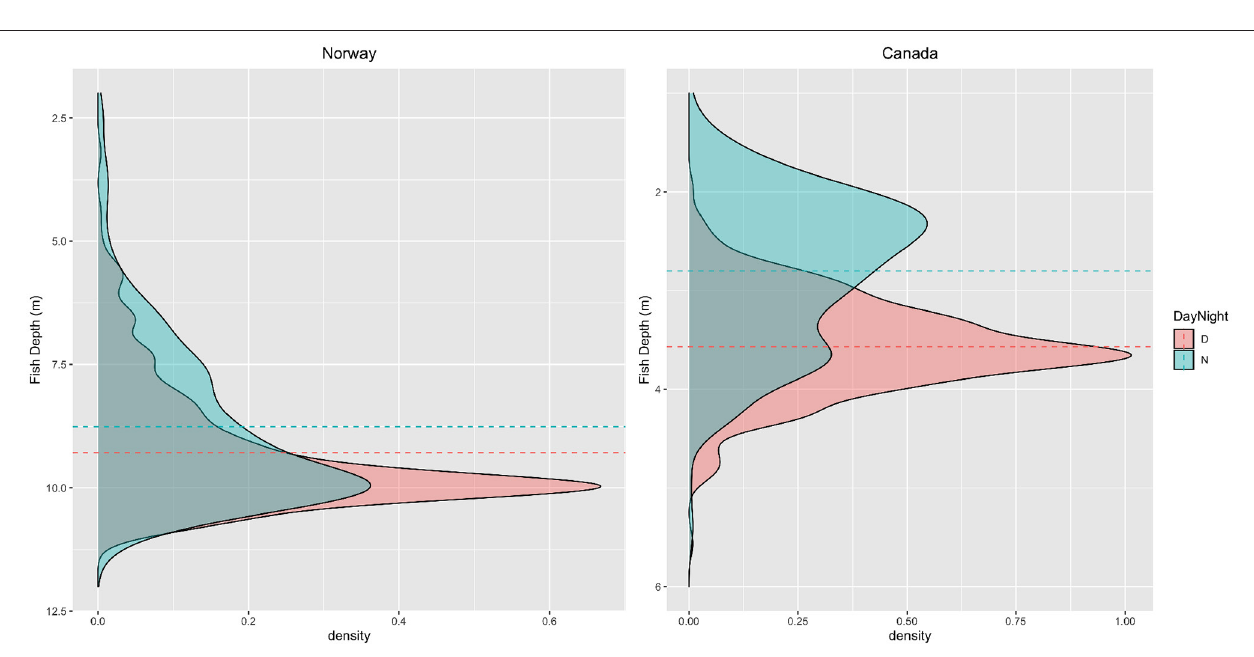
FIGURE 10 | Distribution of fish depth data for the NOR (left) and CAN (right) farm over the duration of the study period. The data is split into daytime and nighttime periods to explore how behaviours vary between those periods. The dashed vertical lines denote the mean for both